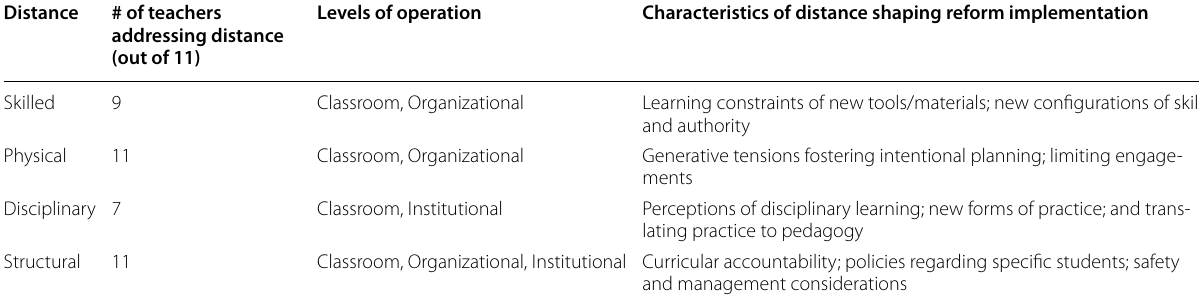
Table 3 Summary of distances findings: teachers addressing each distance and levels of operation